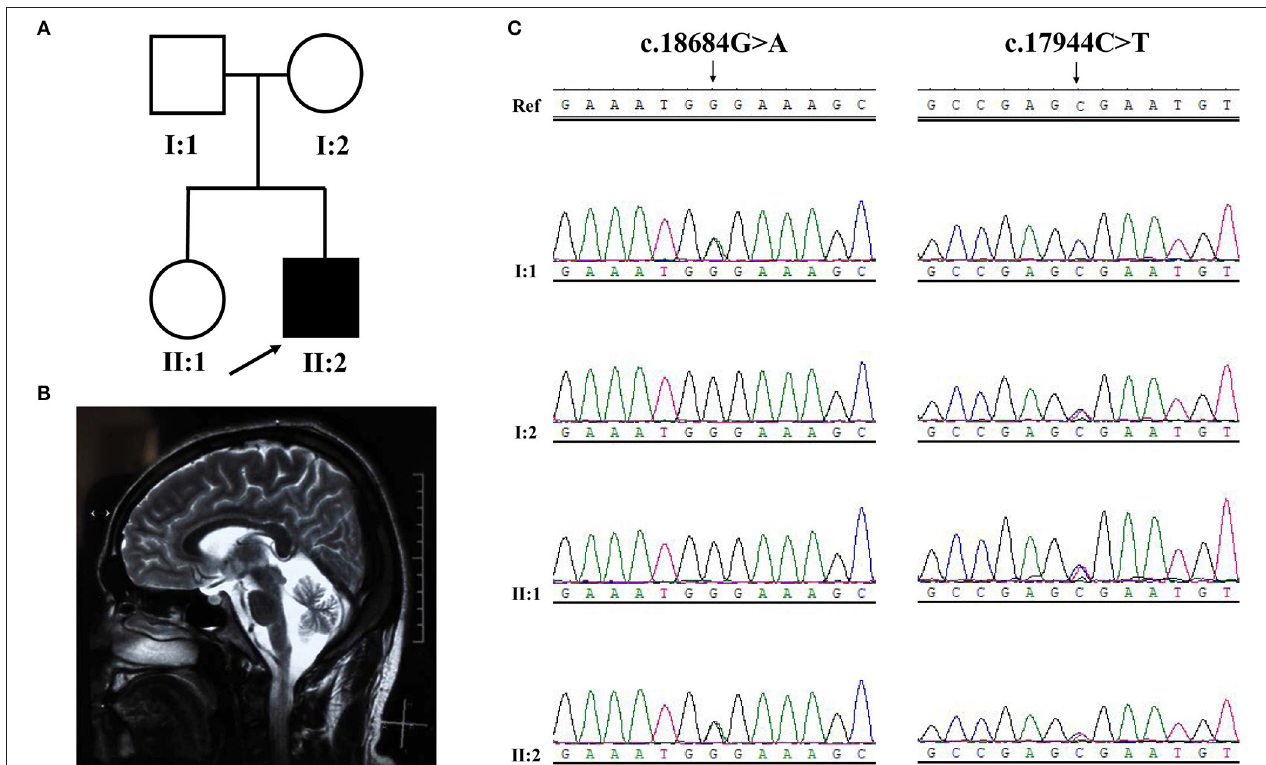
FIGURE 3 | Pedigree structure, clinical features and Sanger sequencing of SYNE1 variant of subjects in Family 2. (A) Pedigree structure. (B) Diffuse cerebellar atrophy on T2-weighted MRI. (C) Segregation of SYNE1 variants identified in subjects of Family 2, whose DNA sample were available. Ref: reference sequence in NCBI.